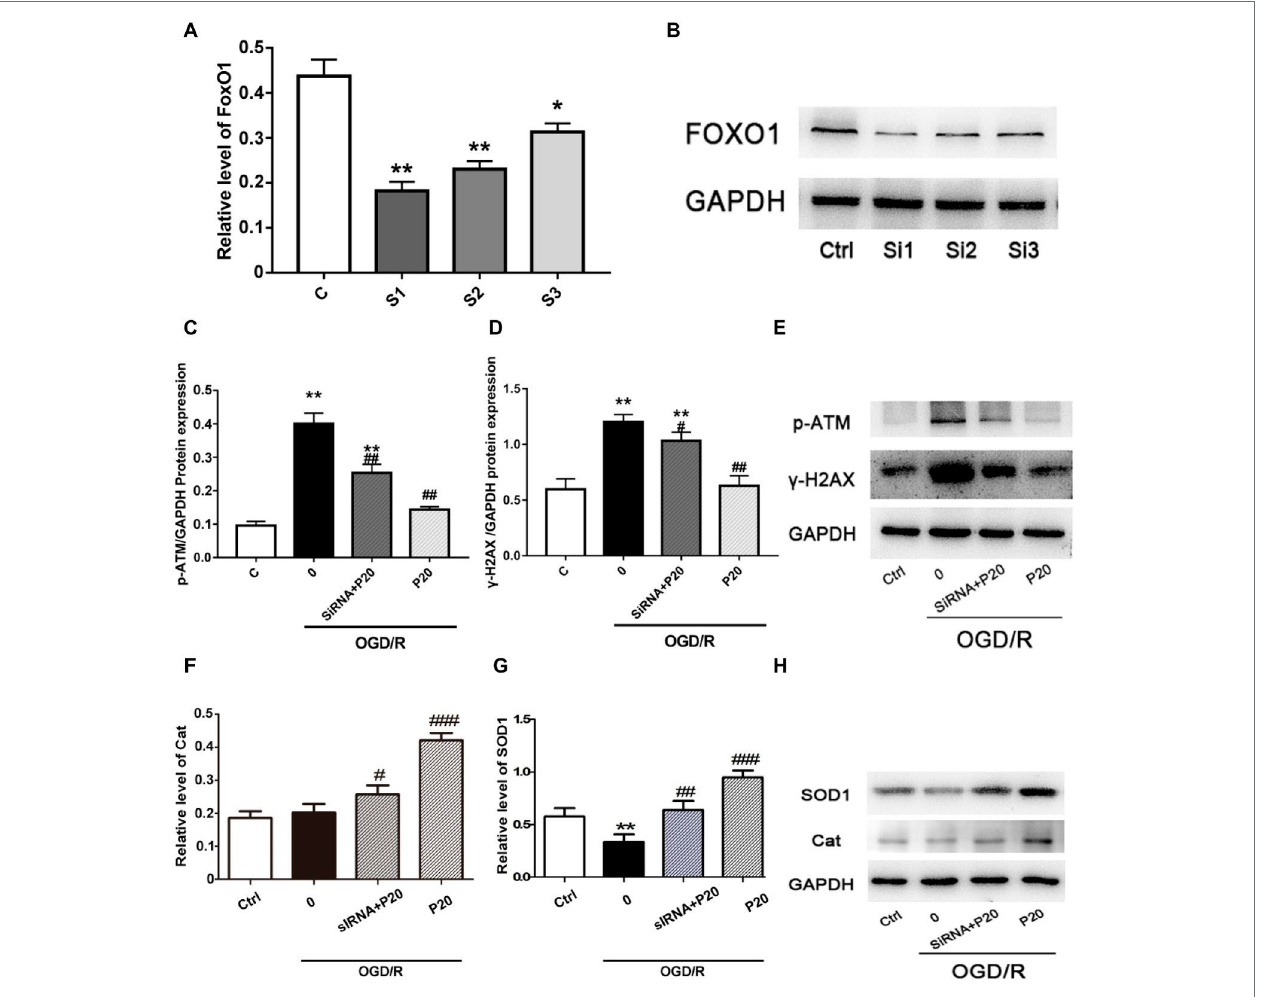
FIGURE 5 | The FoxO1 silence significantly reversed the effect of propofol on DSBs in H9c2 cells during OGD/R insult. (A) and (B) Representative image of FoxO1 silence vesicles in H9c2 cells, which was, respectively, transfected with 50 nM siRNA-FoxO1–1, siRNA-FoxO1–2, or siRNA-FoxO1–3. (C) , (D) , (F) , and (G) : Relative level of γ -H2AX, p-ATM, Cat, and SOD1 in the OGD/R induced and siRNA-transfected H9c2 cells. (E) and (H) Expression of γ -H2AX, p-ATM, Cat, and SOD1 in protein level in H9c2 cells treated with 20 μ M propofol, 50 nM siRNA-FoxO1–1, or both of them. The data are presented as the mean ± SD of three